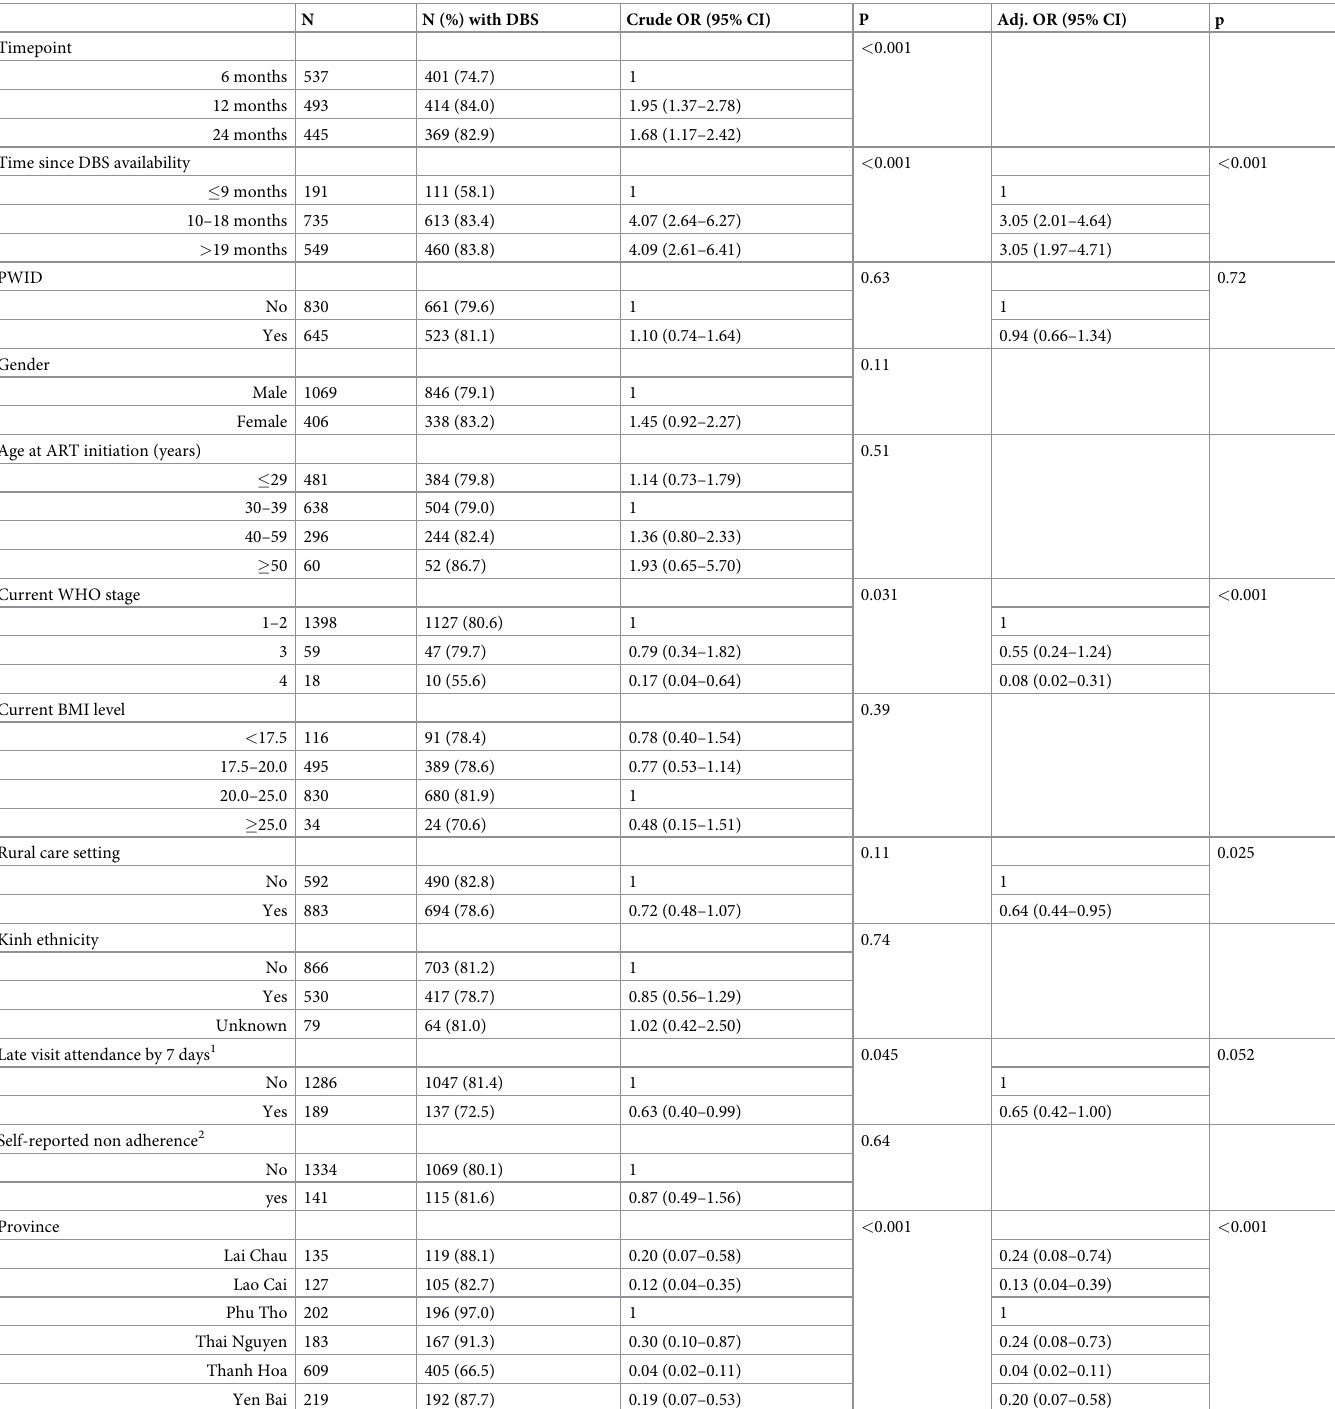
Table 3. Factors associated with DBS coverage (mixed-effects logistic